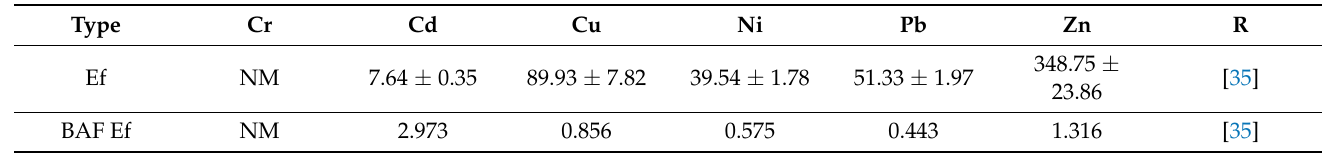
Table 4. The values of the metal content accumulated by Eisenia fetida at the end of the vermicom- posting process (unit: mg/kg, dry weight) (data from